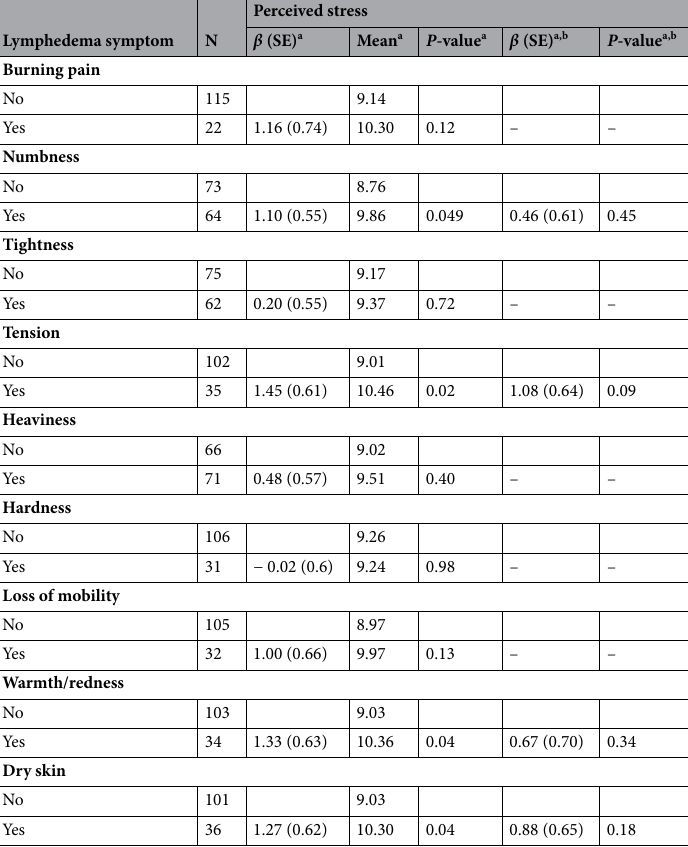
Table 3. Lymphedema symptoms and perceived stress. N number, SE standard error. a Standard analysis of covariance model adjusting for age at 40-month assessment and race/ethnicity was used. b Mutually adjusted for numbness, tension, warmth/redness, and dry skin, and additionally adjusted for change in clothing size/ style due to